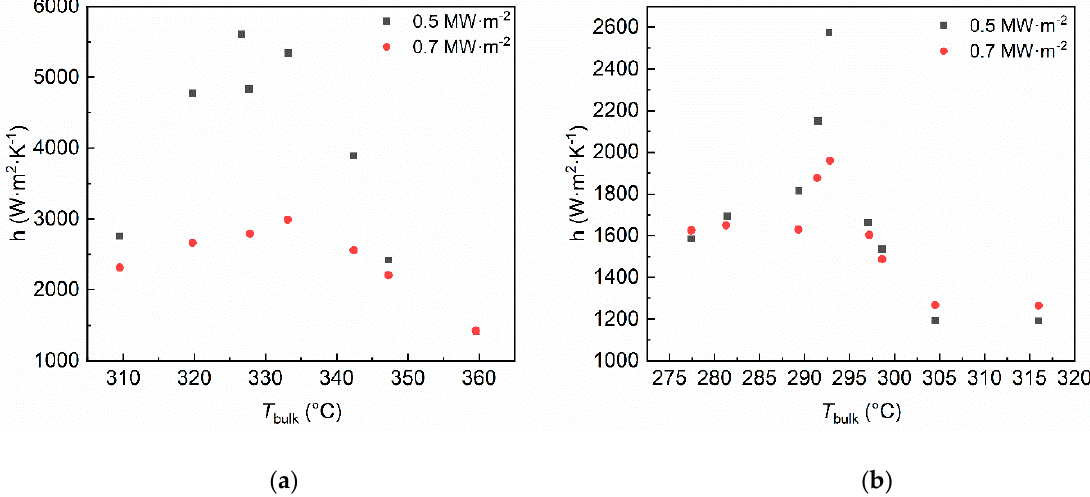
Figure 9. ( a ) Influence of the used heat flux for a water–nitrogen mixture (mf = 40 kg/h, mN2 = 130 Nl/min); ( b ) Influence of the used heat flux for a mixture of water-ethanol–nitrogen (mf = 25 kg/h, mN2 = 220 Nl/min, ). (adapted from